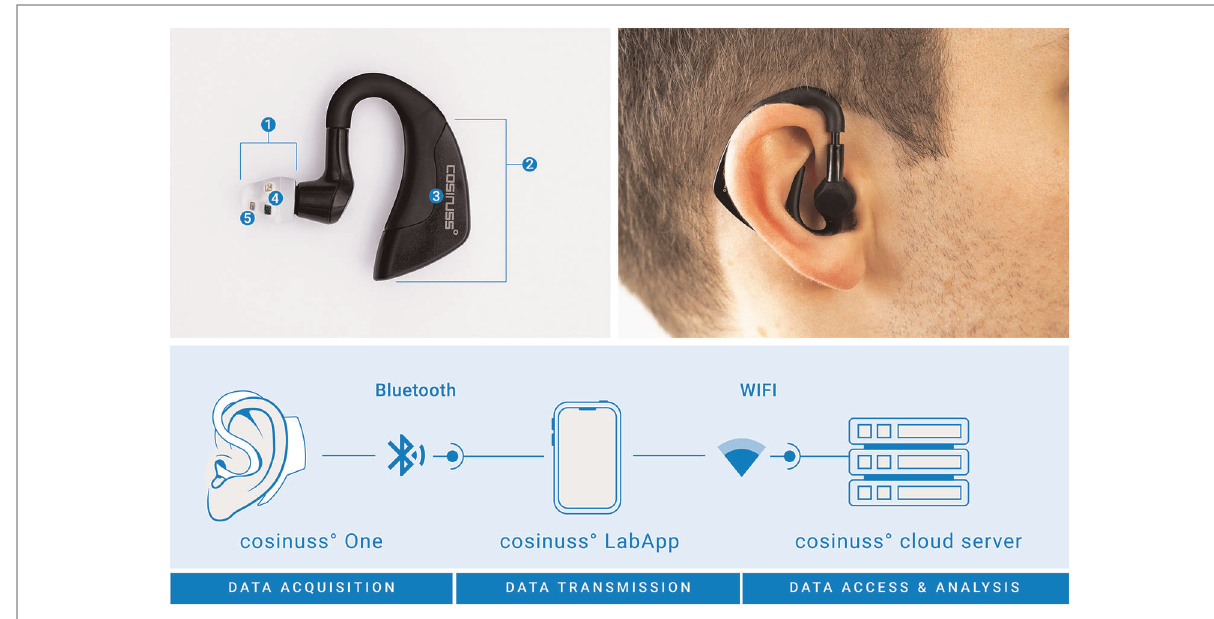
FIGURE 1 Concept of the cosinuss° One in-ear sensor used as a wearable to detect heart rate in the study. Top left image: (1) sensor head, (2) processing unit, (3) accelerometer, (4) temperature sensor, (5) PPG sensor elements. Bottom image: Acquired data are sent to the cosinuss° LabApp smartphone application via Bluetooth, which are then automatically uploaded to the cloud via a Wi-Fi